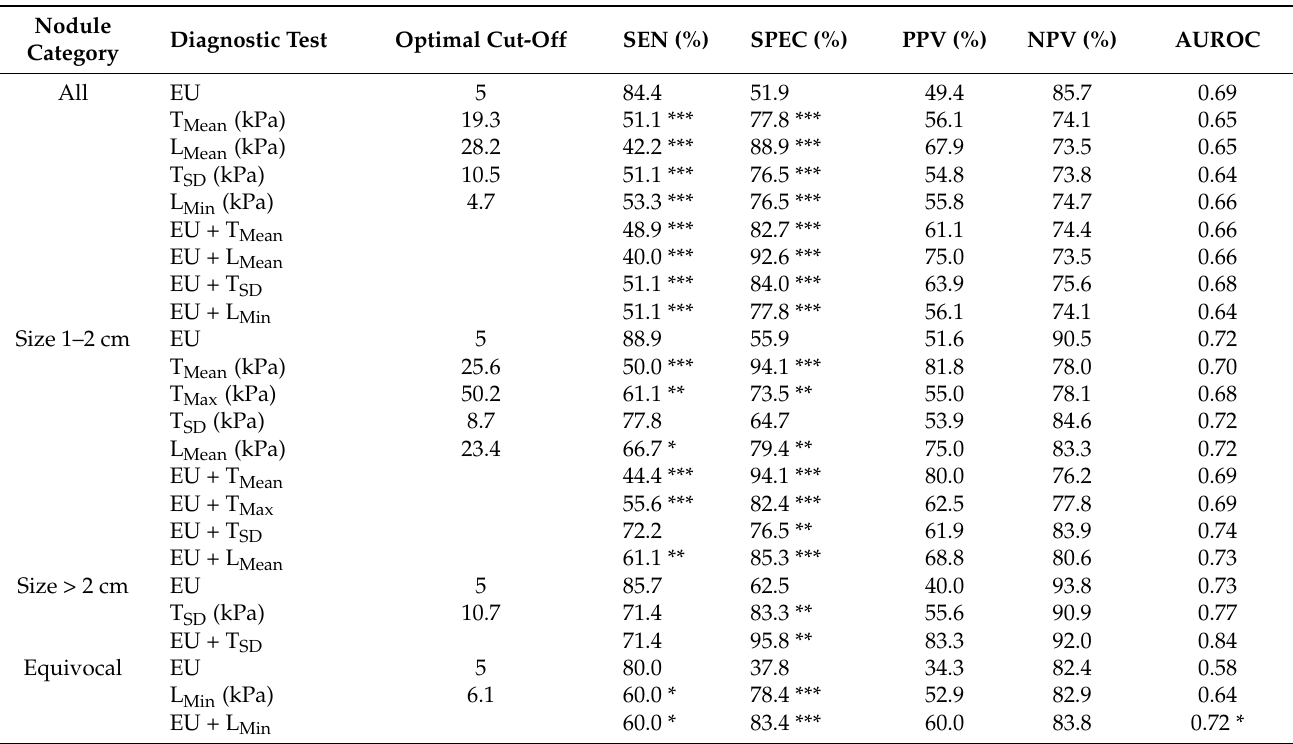
Table 3. Diagnostic performance assessment of sole and combined EU TIRADS and SWE indices based on all nodules, equivocal cytology, and size